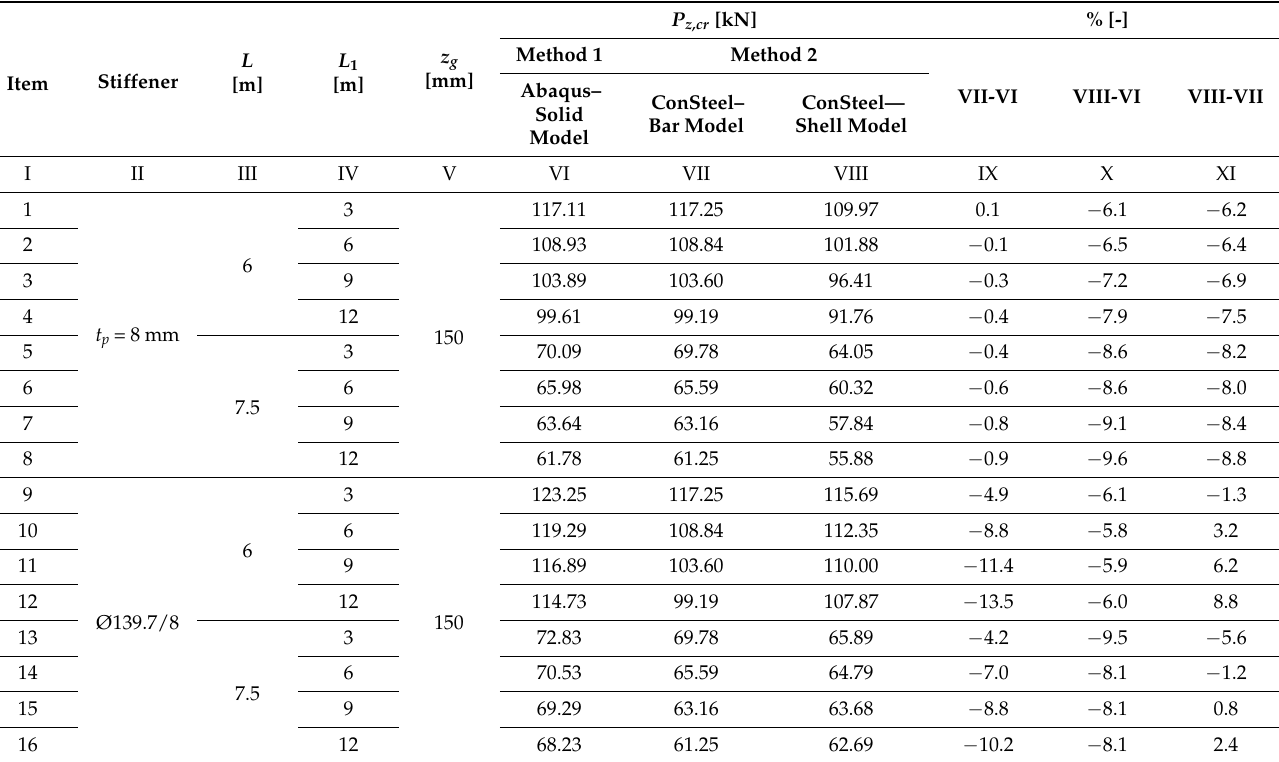
Table 6. Comparison of P z,cr for the H-type grillage loaded with the concentrated force ( z g = + h /2) on the B–E main (critical)